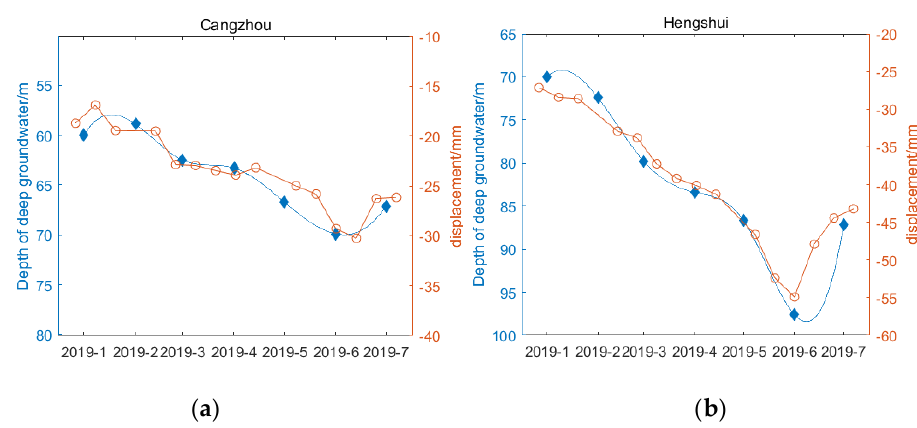
Figure 12. The comparisons between interferometric synthetic aperture radar (InSAR) displacement (pink circle) and the deep groundwater level changes (blue diamond) for Cangzhou ( a ) and Hengshui ( b ), from January 2019 to July